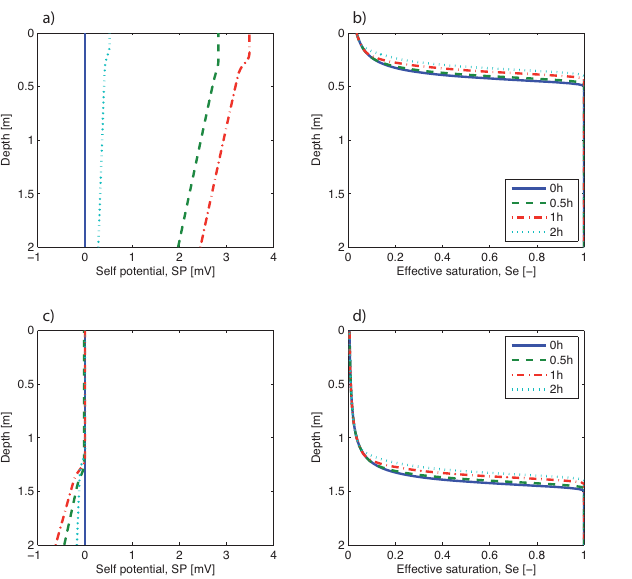
Fig. 9. (a) Variation of the modeled SP signal with depth at differ- ent times for a rainfall event (3mmh − 1 during 1h) with a constant water table located at (a) 0.5m and (c) 1.5m depth (see Fig. 7). (b) and (d) Corresponding values of the effective water saturation.